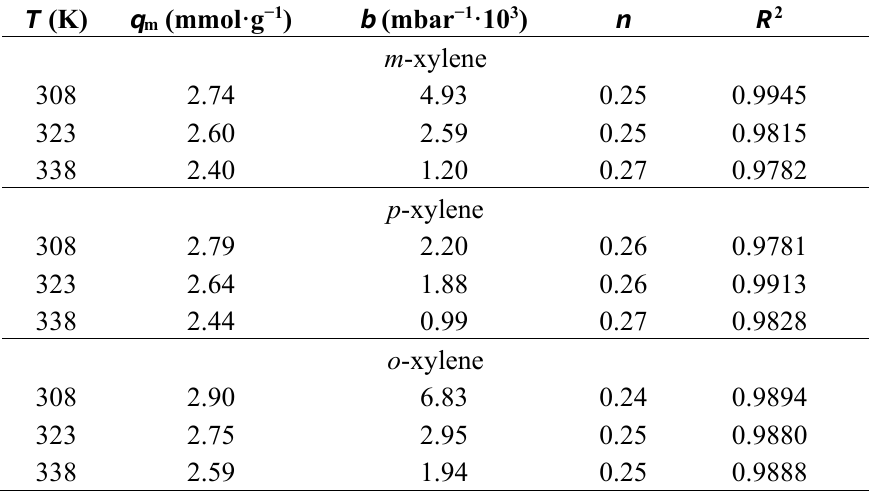
Table 2. Toth fitting parameters of xylene isomers on Beta-0.